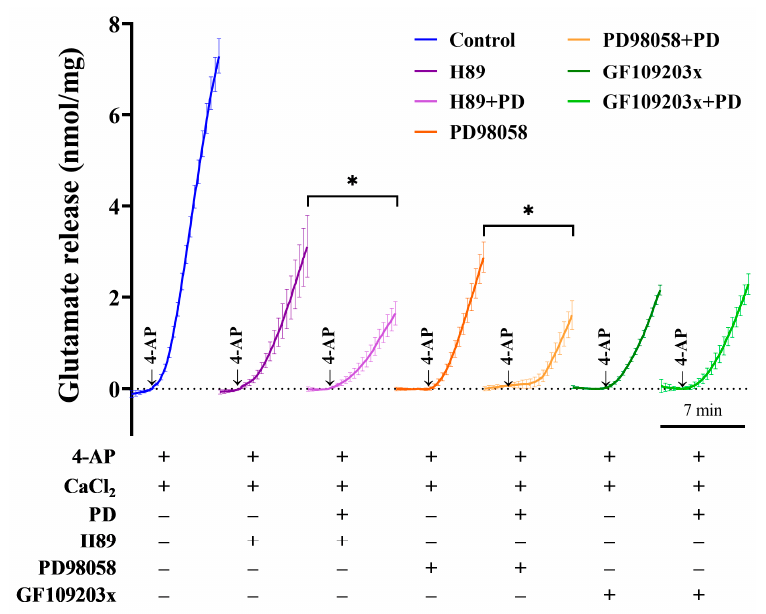
Figure 7. The PKC pathway is responsible for the PD-mediated inhibition of glutamate release. Isolated synaptosome were divided into 7 experimental groups as follows: (i) control, (ii) H89, (iii) H89 + PD, (iv) PD98059, (v) PD98059 + PD, (vi) GF109203X and (vii) GF109203X + PD. The PD-mediated inhibition of 4AP-evoked glutamate release is abolished by the PKC inhibitor GF109203X (5 µM) but not the PKA inhibitor H89 (10 µM) or MAPK/ERK inhibitor PD98059 (20 µM). Data are presented as the means ± SEMs of 5 independent experiments from isolated synaptosomes ( n = 5 per group). * p < 0.01 versus H89 or PD98059 treatment.